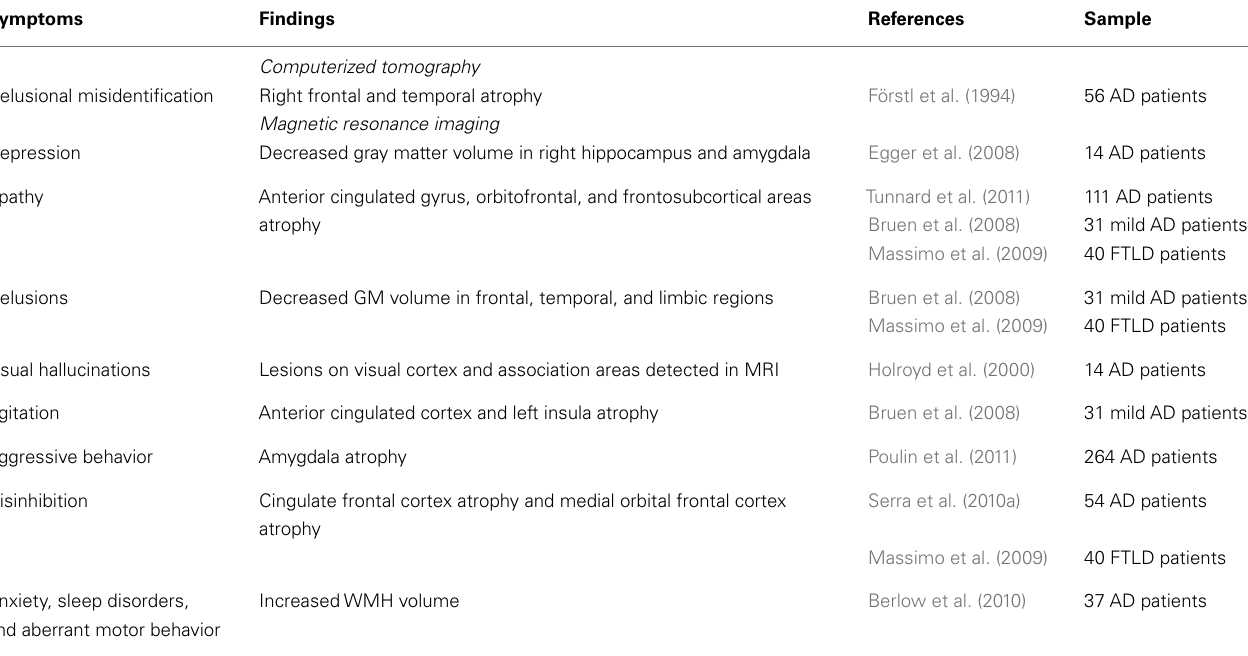
Table 6 | BPSD and structural changes in neuroimaging exams.